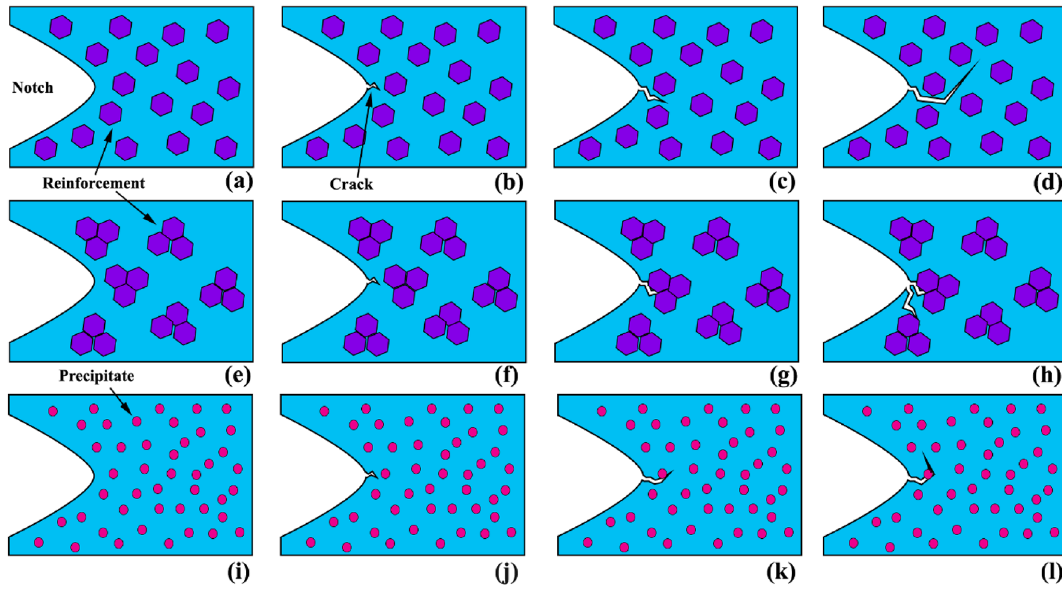
Figure 23. Schematics of crack propagation resistance mechanism during thermal cycles in composite and precipitated hardened sample: ( a – d ) composite with uniform reinforcement distributions, ( e – h ) composite with cluster reinforcement distributions, and ( i – l ) aged